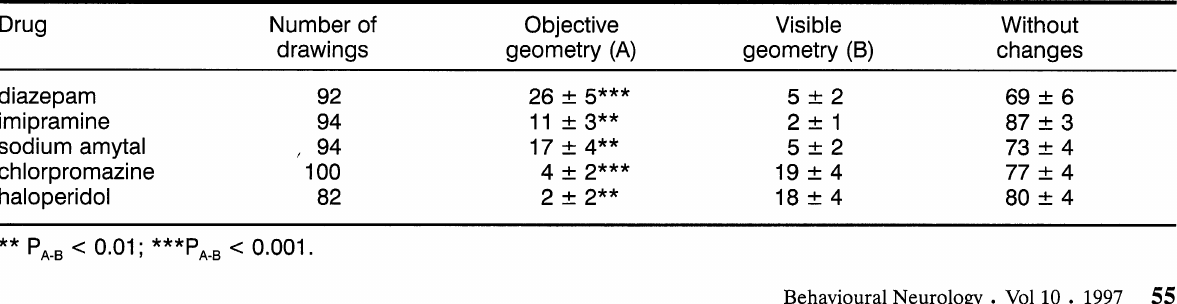
TABLE II. Frequency (%) of representations of visible and objective geometry of space after injection with psychotropic drugs